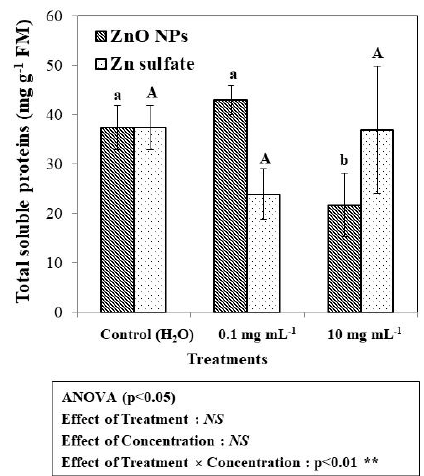
Fig. 7: Levels of total soluble proteins in the embryonic axes of Lathyrus sativa L. seeds germinated for 4 days in the presence of distilled wa- ter (Control) or solutions of ZnO NPs and ZnSO 4 at concentrations of 0.1 mg ml -1 and 10 mg ml -1 . Values are means (±SD) of 5 indepen- dent measurements. Letters a-c and A-C denote statistic classes, re- spectively, for ZnO NP and Zn sulfate, using Duncan test (α=0.05). Differences are significative, at *: 0.01≤P<0.05, **: 0.001≤P<0.01, ***: P<0.001, and non significant NS at